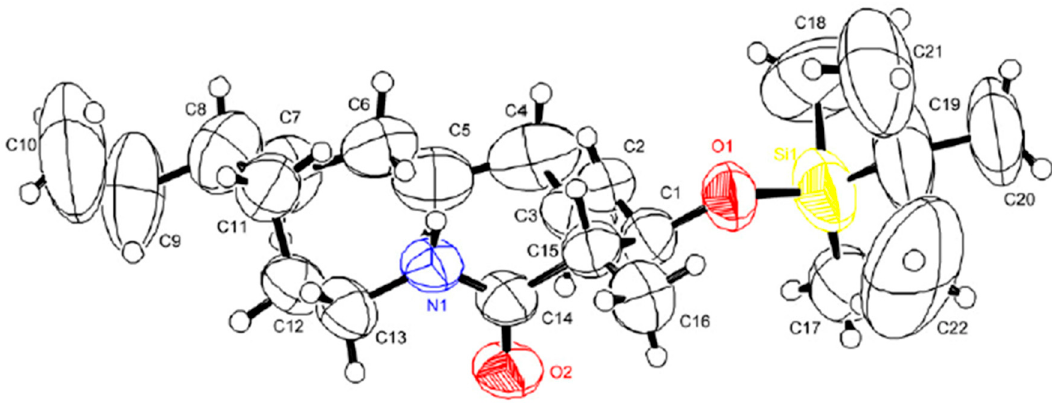
Figure 3. X-ray crystallographic structure of 32 . Displacement ellipsoids are drawn at the 50% probability level and H atoms are shown as small spheres of arbitrary radii; black = carbon, red = oxygen, blue = nitrogen, and yellow = silicon.